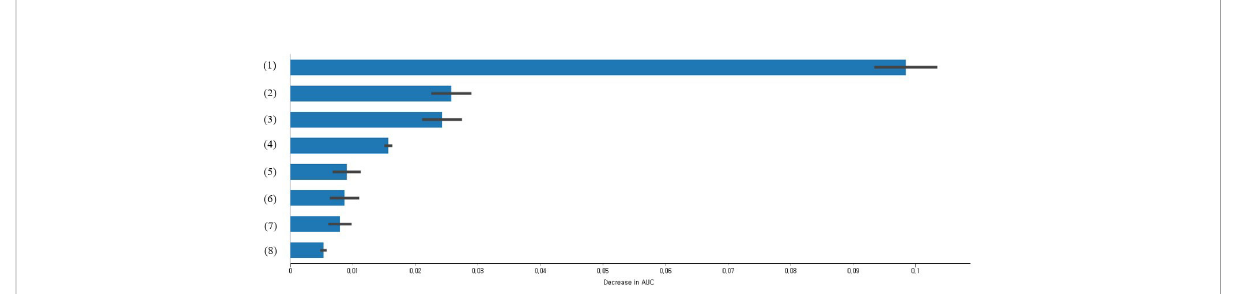
FIGURE 1 Feature importance of impaired fasting glucose predictors in non-diabetics based on CatBoost (only the top eight variables are presented); (1) Age (1 = 30-39 years old, 2 = 40-49 years old, or 3 = 50-64 years old); (2) High cholesterol (0 = no or 1 = yes); (3) WHtR (1 = <0.5 or 2 = 0.5 ≤ ); (4) BMI (1 = underweight, 2 = normal weight, 3 = pre-obesity class, 4 = class 1 obesity, or 5 = class 2 obesity or higher); (5) Drinking more than one shot per month for the past year (0 = no or 1 = yes); (6) Marital status (1 = living with a spouse, 2 = separated/divorced/bereaved, or 3 =